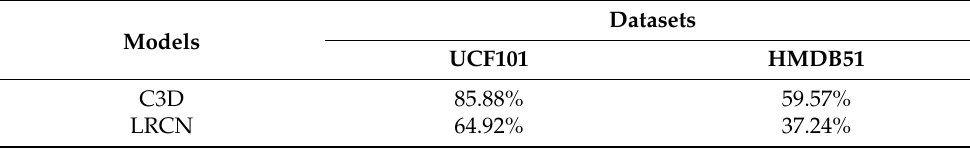
Table 1. Test accuracy of threat